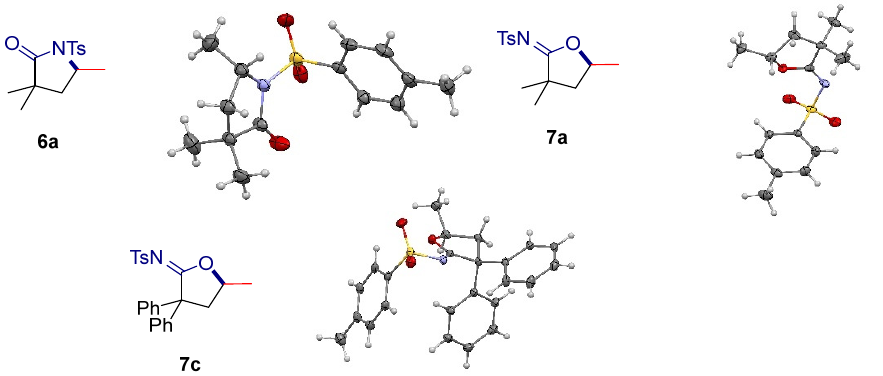
Figure 6. Sc(OTf) 3 -catalyzed cyclization of N -protected δ -alkenamides. c a isolated yields; b ratio of N -selective product vs. O -selective product determined by 1 H NMR on the crude reaction mixture; c all reactions run under thermal conditions unless otherwise stated; d run under microwave condi- tions.